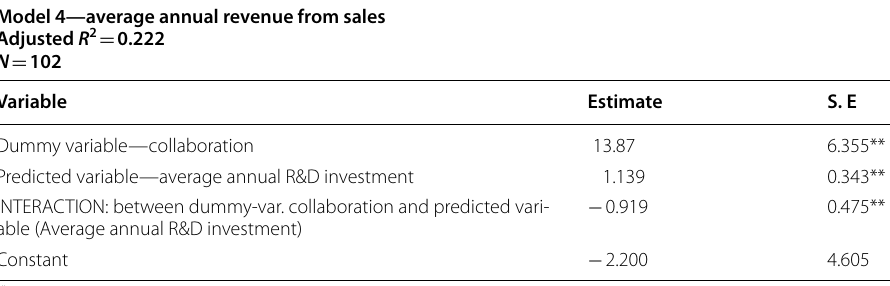
Table 4 Multiple regression model for evaluating the contribution of collaboration to product revenue and interaction